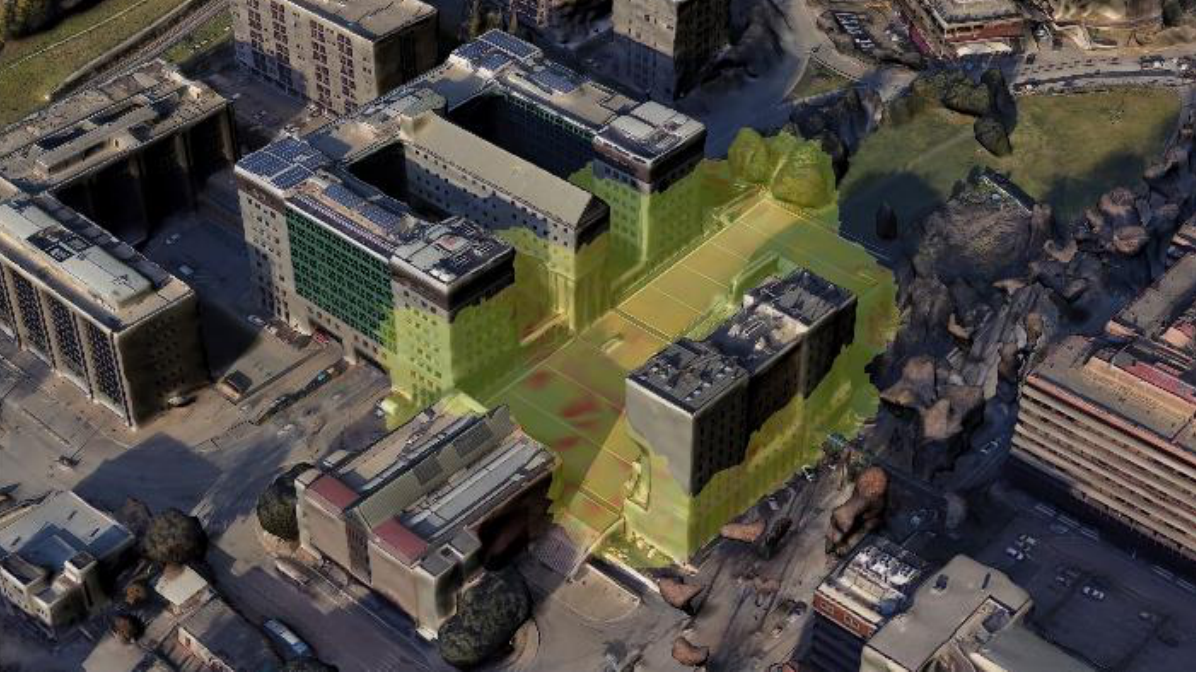
Figure 1 – Representing perception: mesh with the value attribute calculated through the circumplex